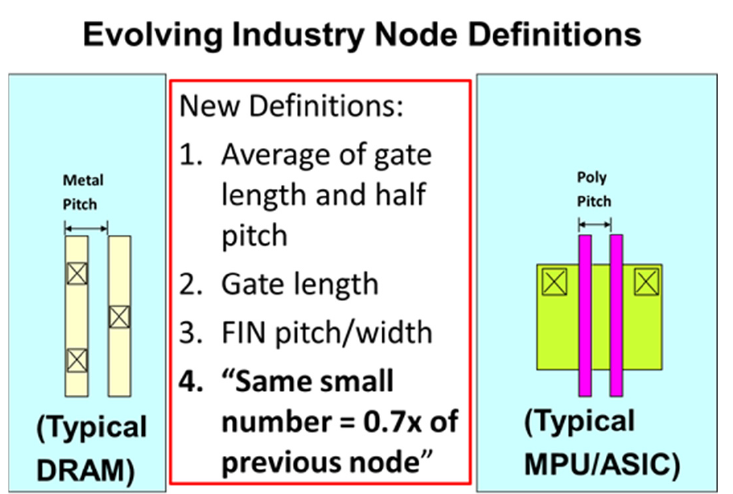
Figure 9. Evolution of technology node definition used by industry.